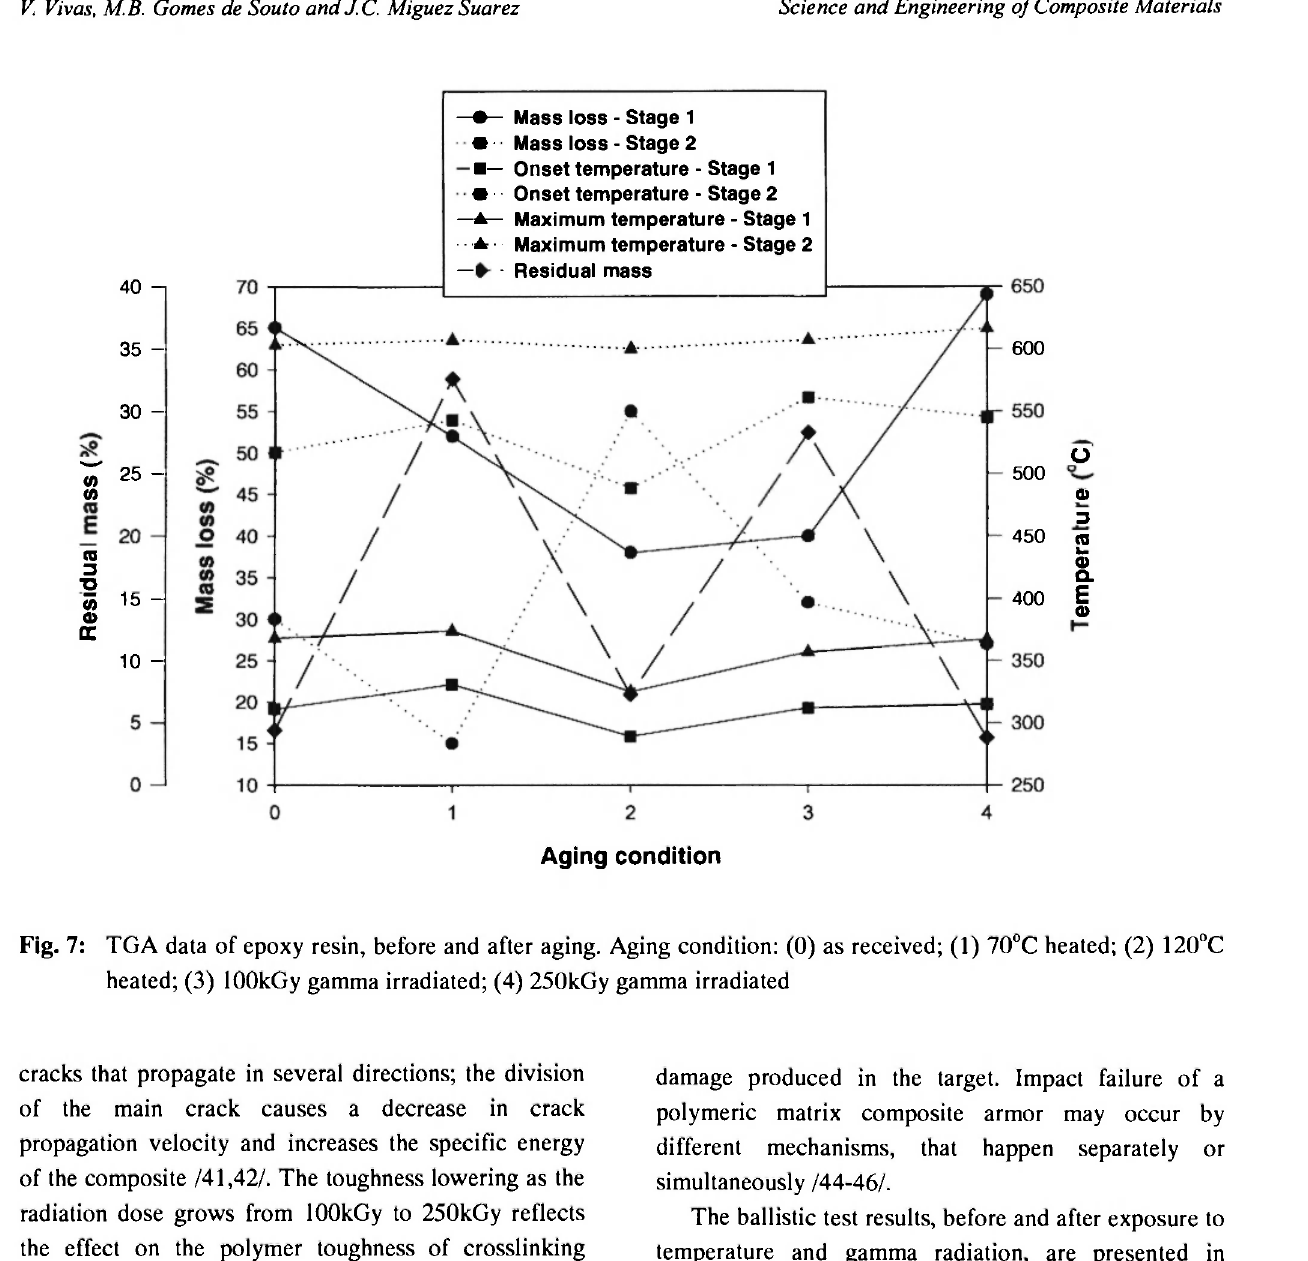
Fig. 7: TGA data of epoxy resin, before and after aging. Aging condition: (0) as received; (1) 70°C heated; (2) 120°C heated; (3) lOOkGy gamma irradiated; (4) 250kGy gamma